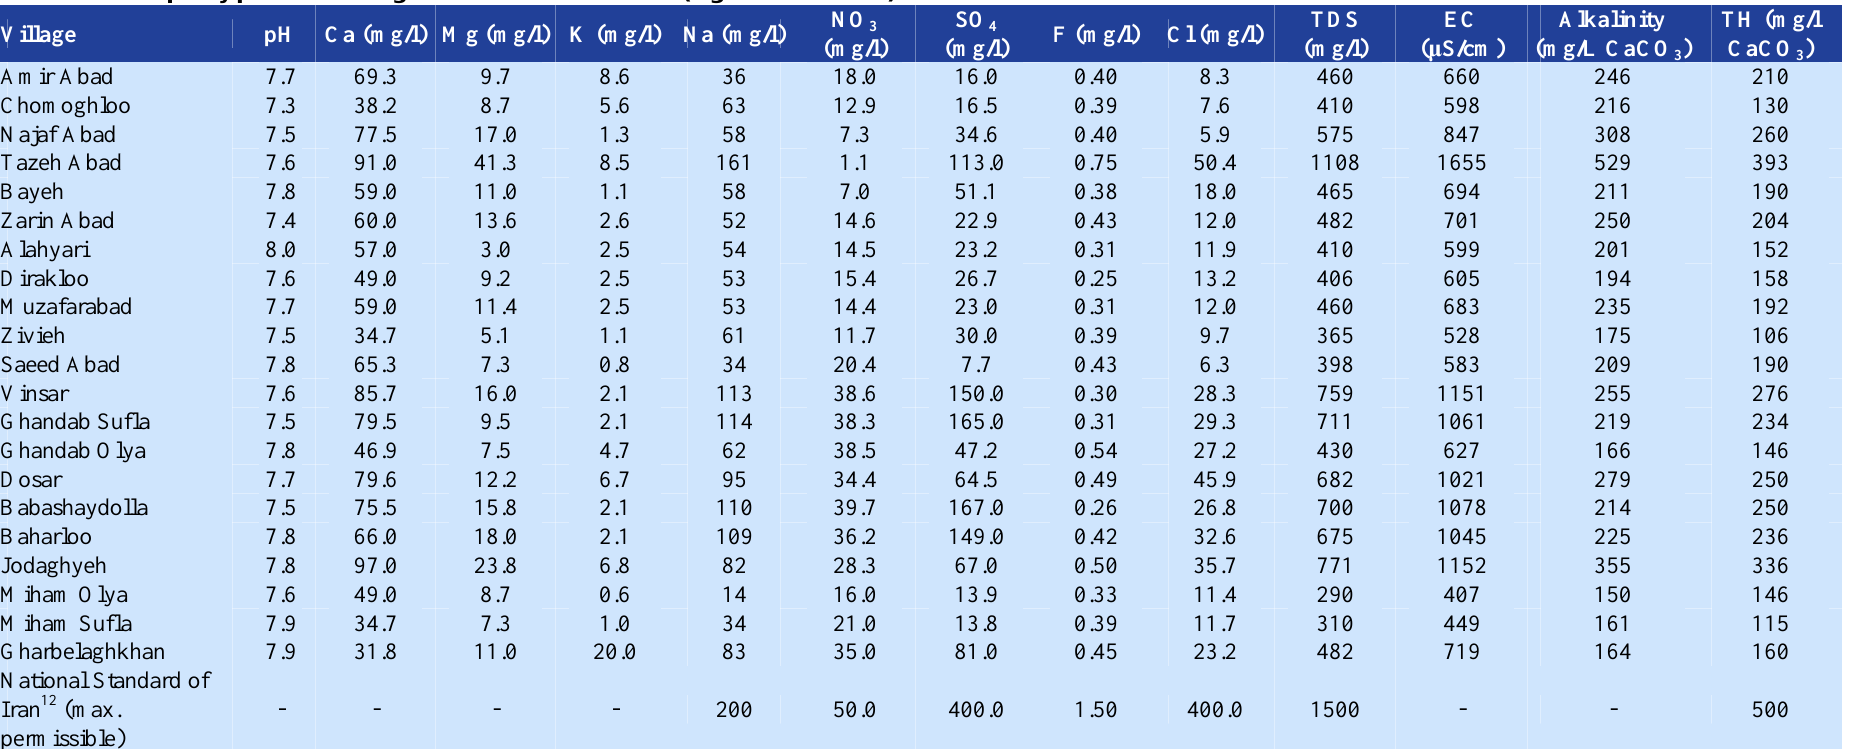
Table 1. Water quality parameters of groundwater in rural areas (high-water season) Village